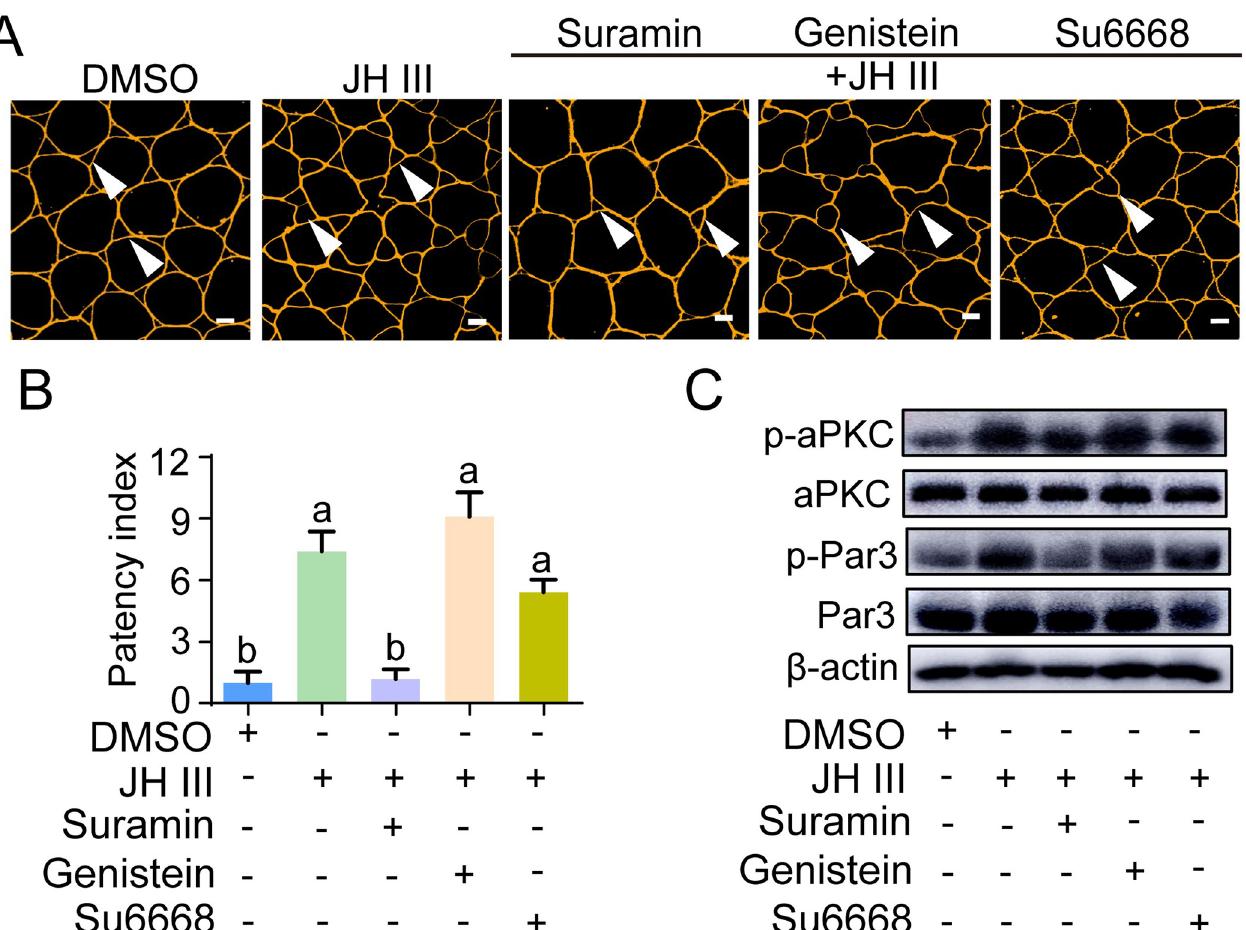
Fig 6. The role of GPCR in patency opening and phosphorylation of aPKC and Par3. (A) Effect of GPCR inhibitor suramin (1 μ M) as well as RTK inhibitors genistein (10 μ M) and Su6668 (10 μ M) on JH-induced patency of cultured follicular epithelium from 7-day-old adult females. Arrow heads indicate patency. Scale bars: 5 μ m. (B) Statistical analysis of patency index in cultured follicular epithelia treated with DMSO, JH, suramin, genistein and Su6668. Means labeled with different letters indicate significant difference at P < 0.05. n = 8–10. (C) Effect of suramin, genistein and Su6668 treatment on JH-stimulated phosphorylation of aPKC and